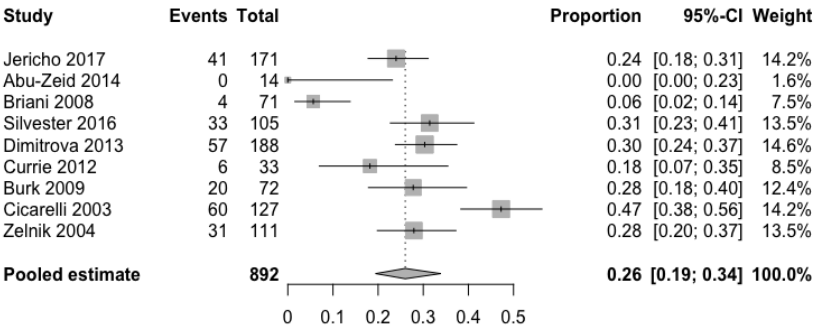
Figure 2. Pooled mean prevalence of headache in adults with coeliac disease.